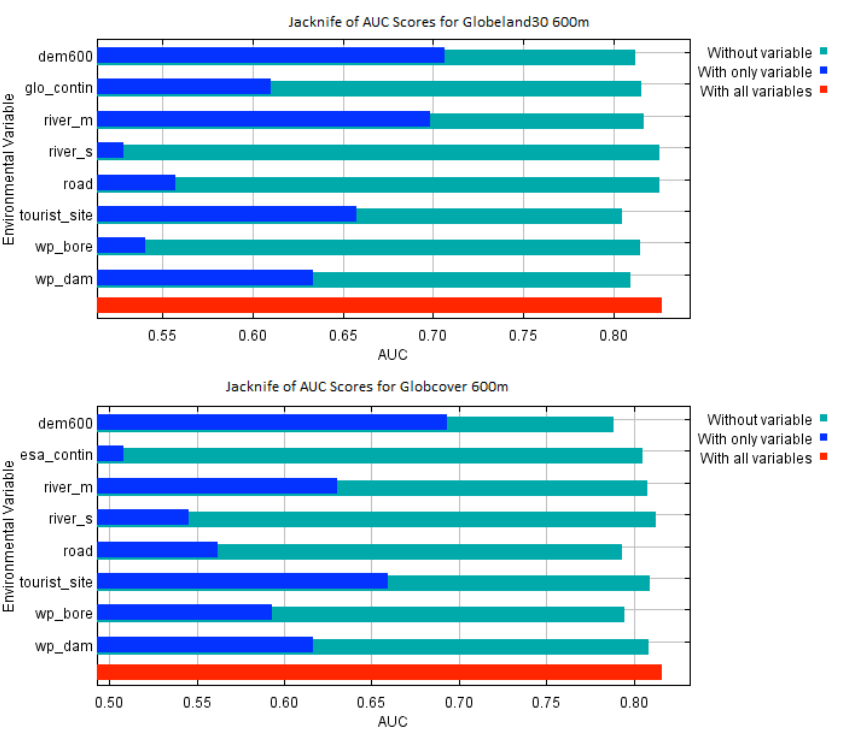
Figure 4. Jackknife tests of variable importance for Globeland30 (top, glo_contin) and Globcover (bottom, esa_contin) models at 600 m. The explanatory power of each individual parameter relative to the total AUC score is represented by the blue bar. The percent contribution of each variable to the overall model performance remained fairly consistent across all models